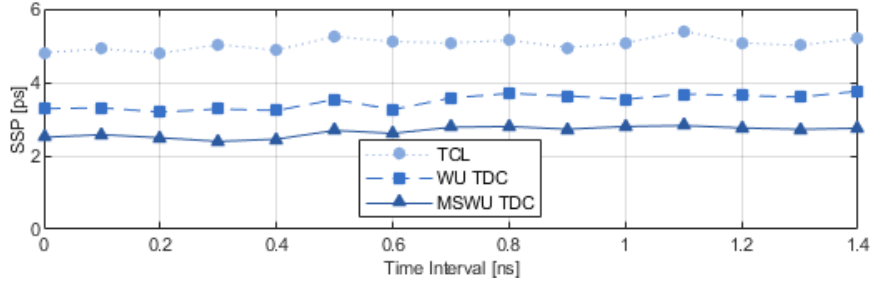
Figure 11. Single-shot precision test for different TDCs and for various time intervals.